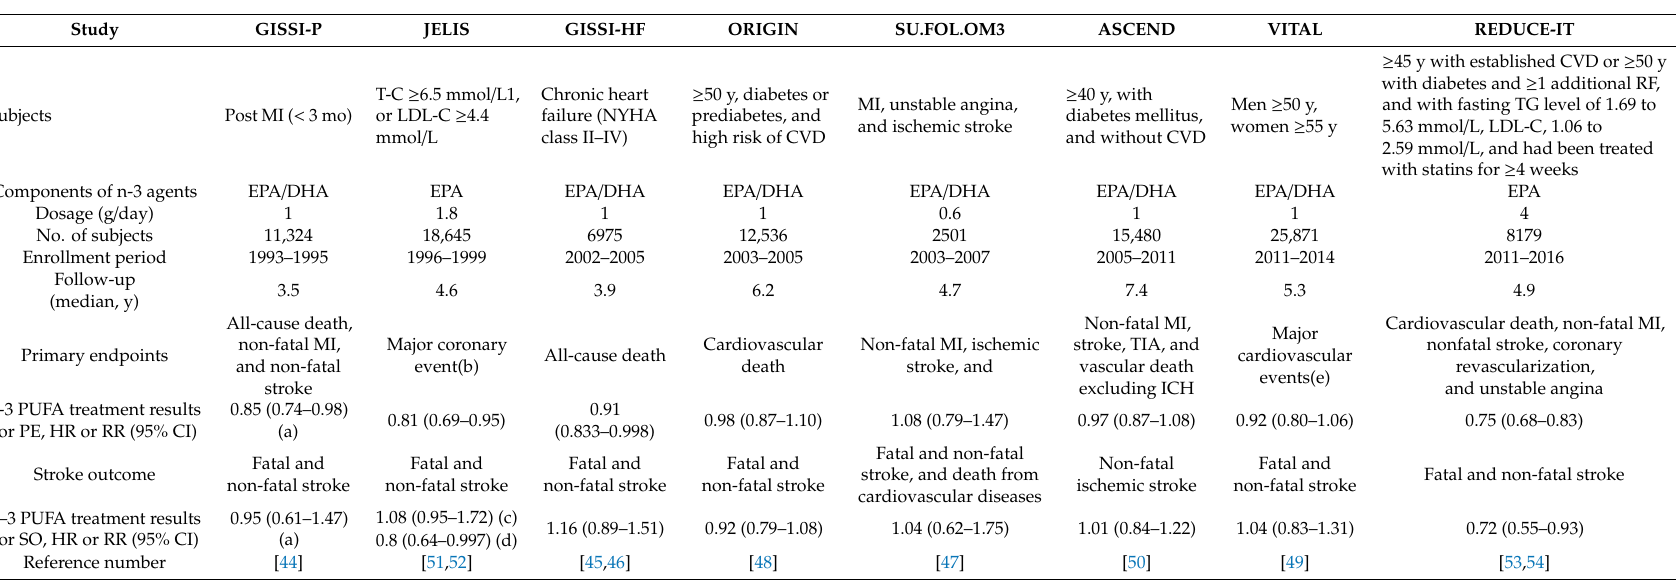
Table 1. Review of large-scale clinical trials of omega-3 polyunsaturated fatty